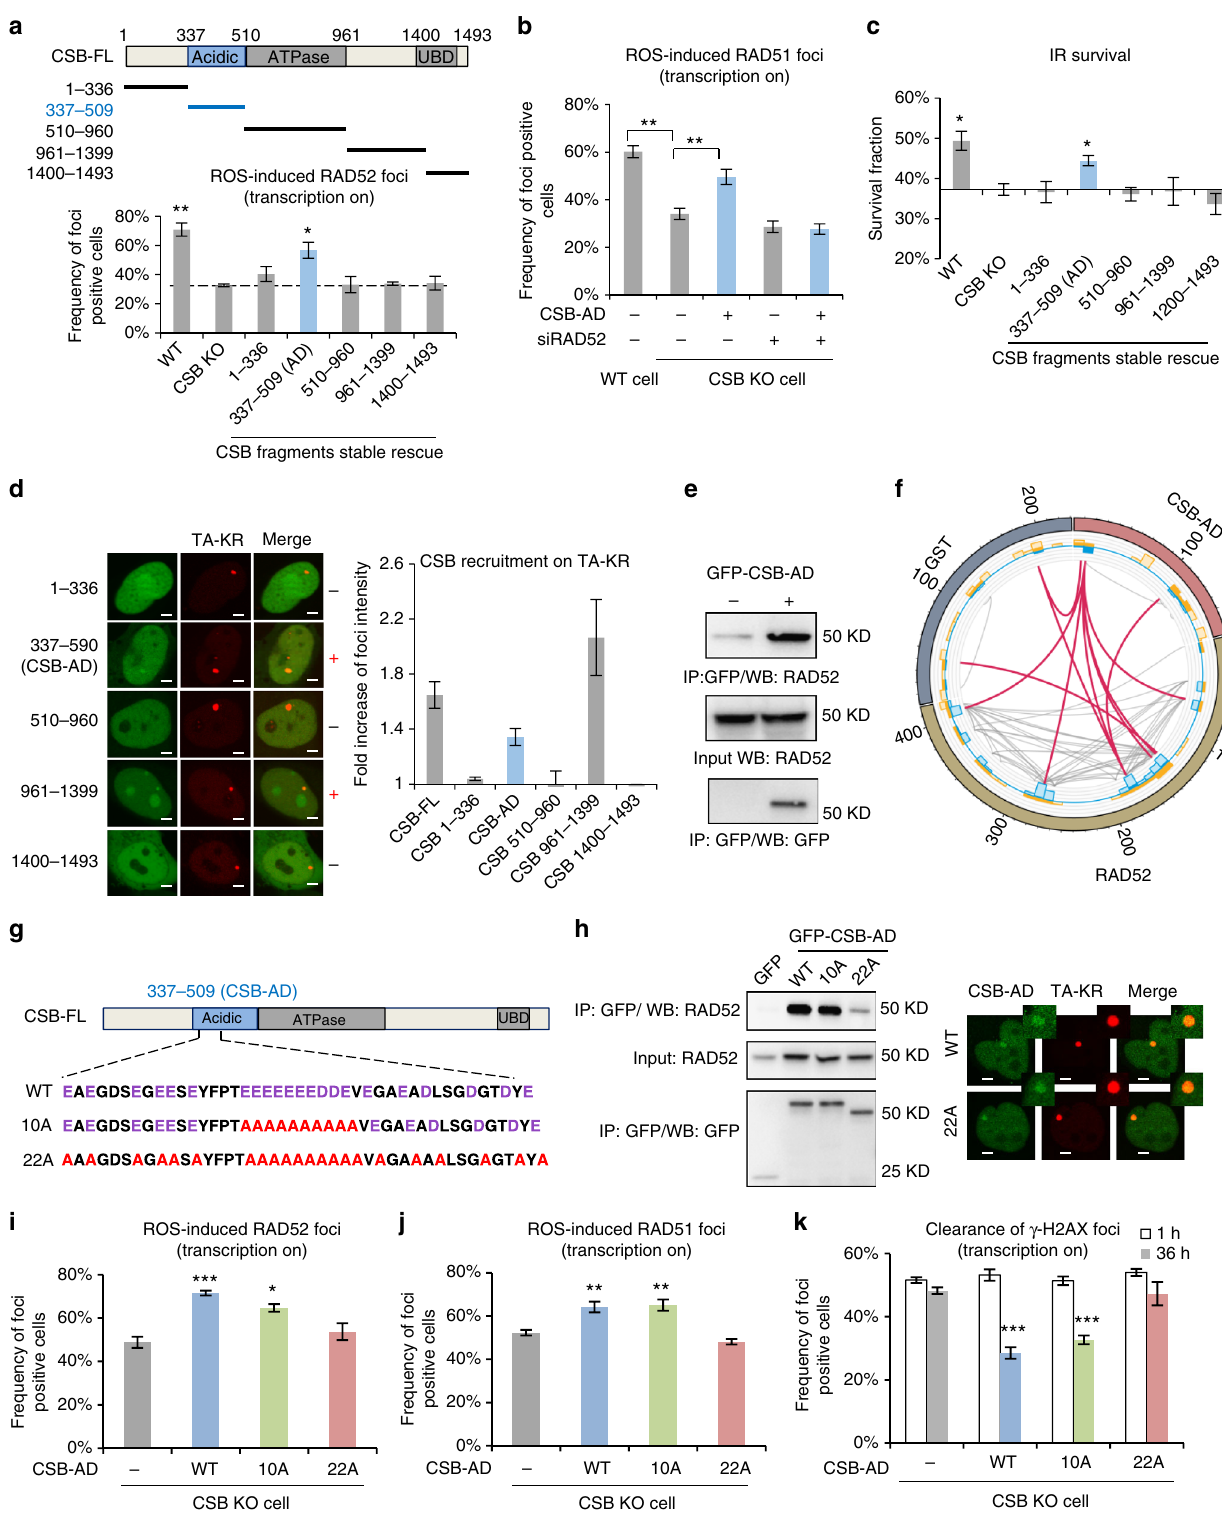
The RNAPII inhibitor 5,6-Dichlorobenzimidazole 1- β -D- ribofuranoside (DRB) sensitized BRCA2 knockdown cells